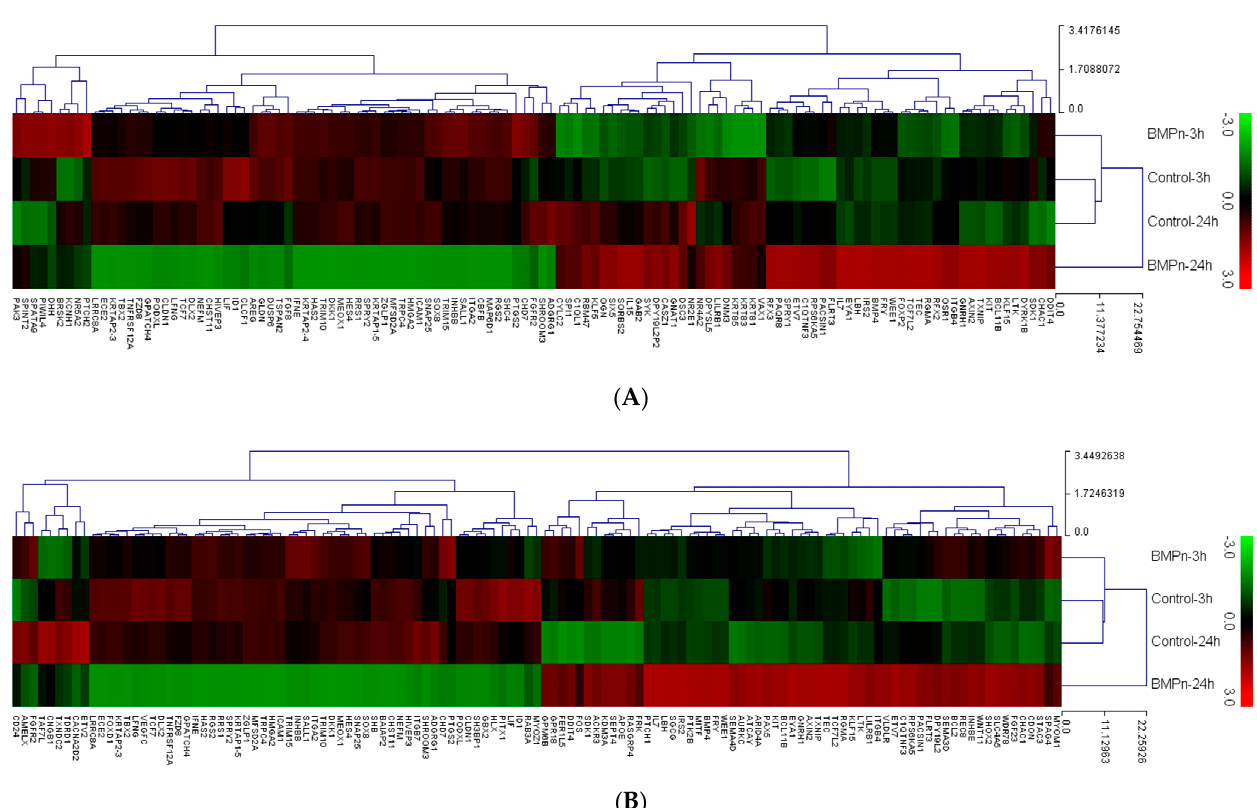
Figure 5. Clustering analysis of differentially expressed mRNA related to cell differentiation ( A ) BMP-7 at 24 h/control at 24 h and ( B ) BMP-7 at 24 h/BMP-7 at 3 h (fold change fold change of greater than 2, log2 normalized read counts >4 were selected).